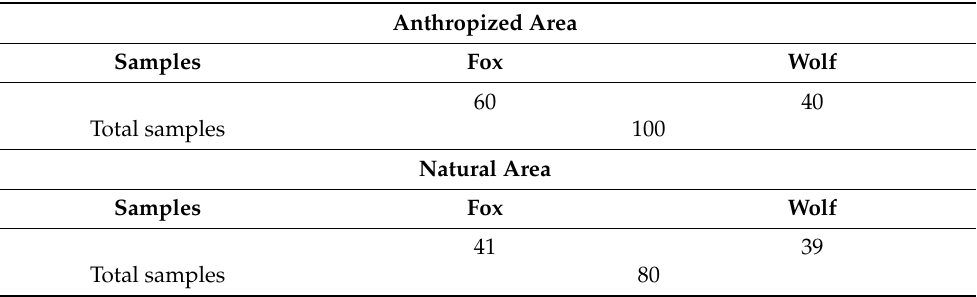
Table 1. Number of red fox and gray wolf fecal samples collected in anthropized and natural areas from Tuscany (Central Italy) and examined for parasites.